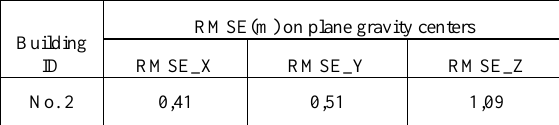
Table 12. RMSE values obtained for the planes of the building No.